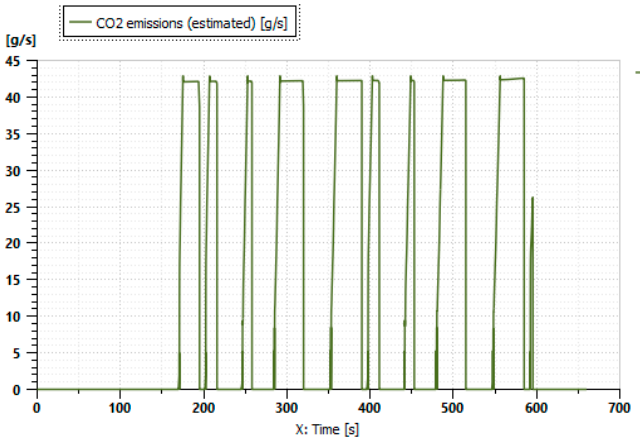
Figure 16. The variation in the CO 2 release.